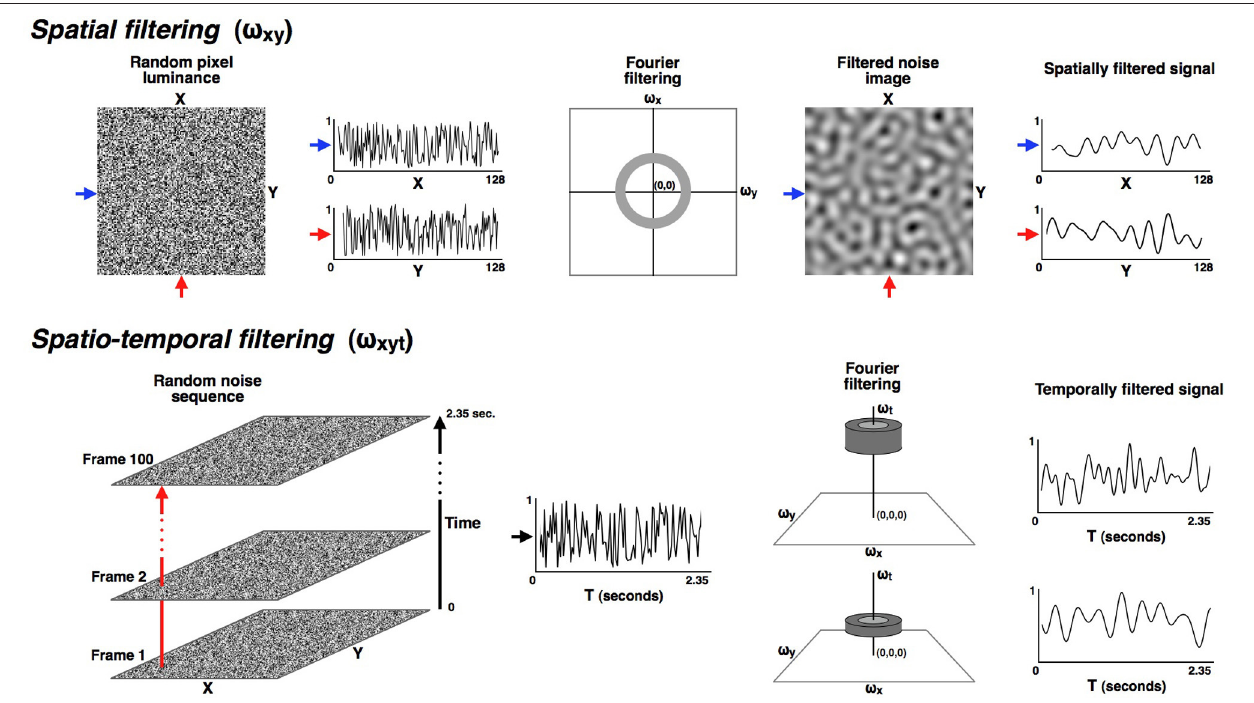
these experiments, with each band having a full-width of 0.33 octaves (where octaves are calculated as the base-two logarithm of the ratio of the upper and lower cut-off frequencies). The pass-bands were all separated by one octave and had center frequencies of: 0.59, 1.18, 2.37, 4.73, 9.47, and 18.93Hz. Since the time dimension is orthogonal to the (x, y) plane it could be manipulated without altering the spatial frequency range, which remained constant at 0.8 to 1.6cyc/deg for all conditions.